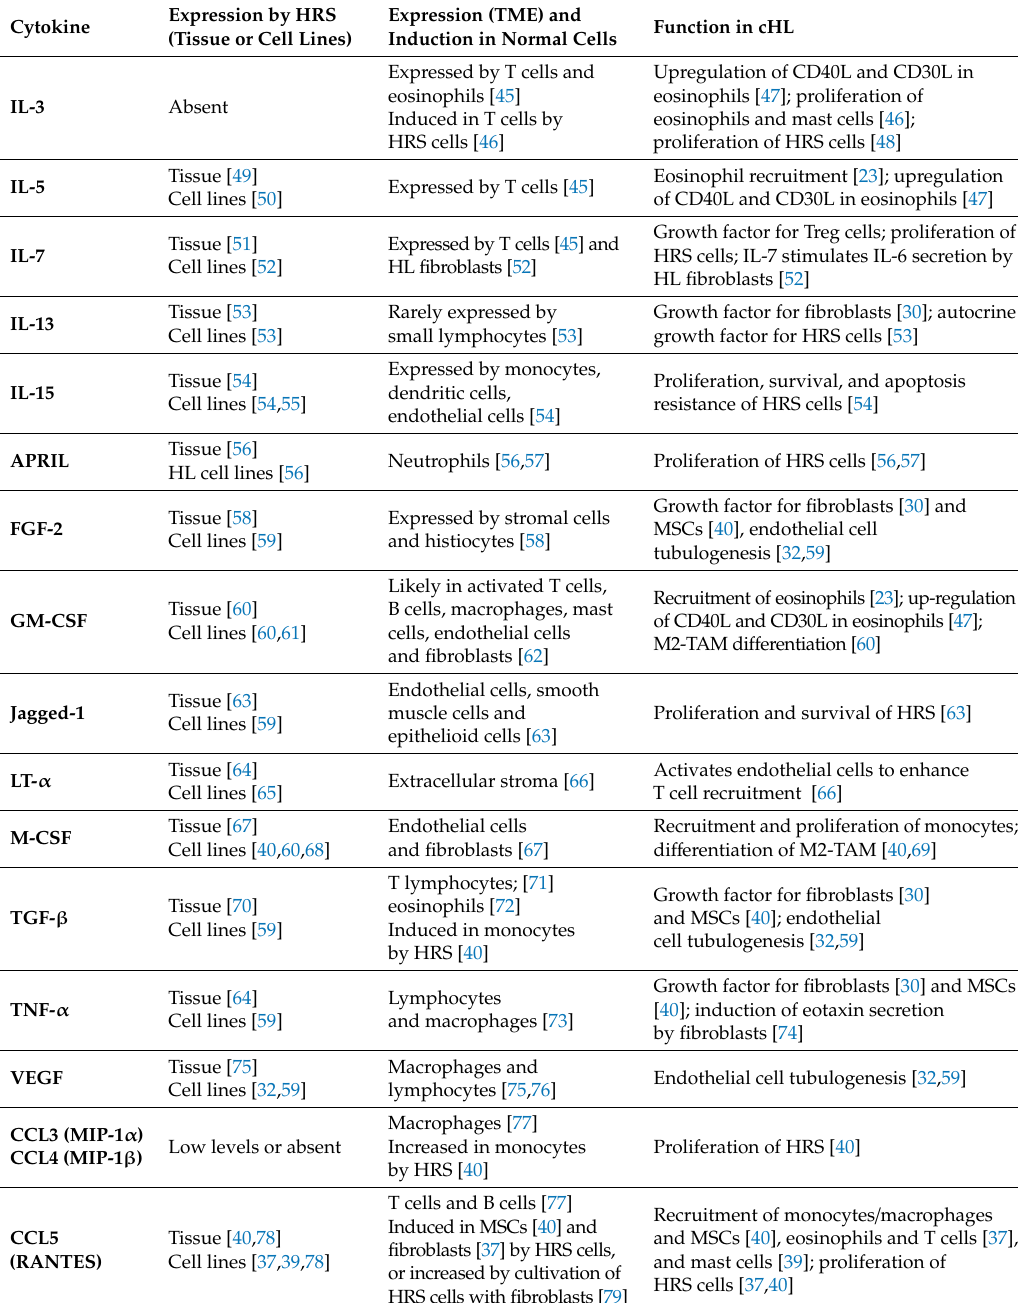
Table 1. Cytokine and chemokine expression, induction and function in Hodgkin